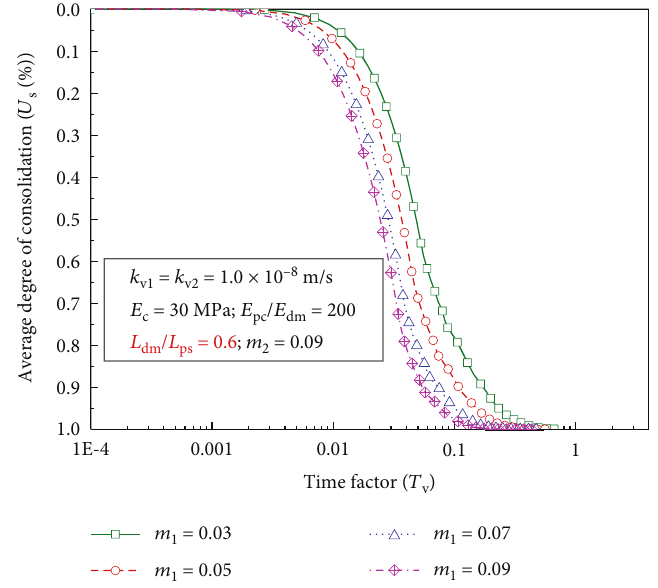
Figure 7: E ff ect of m